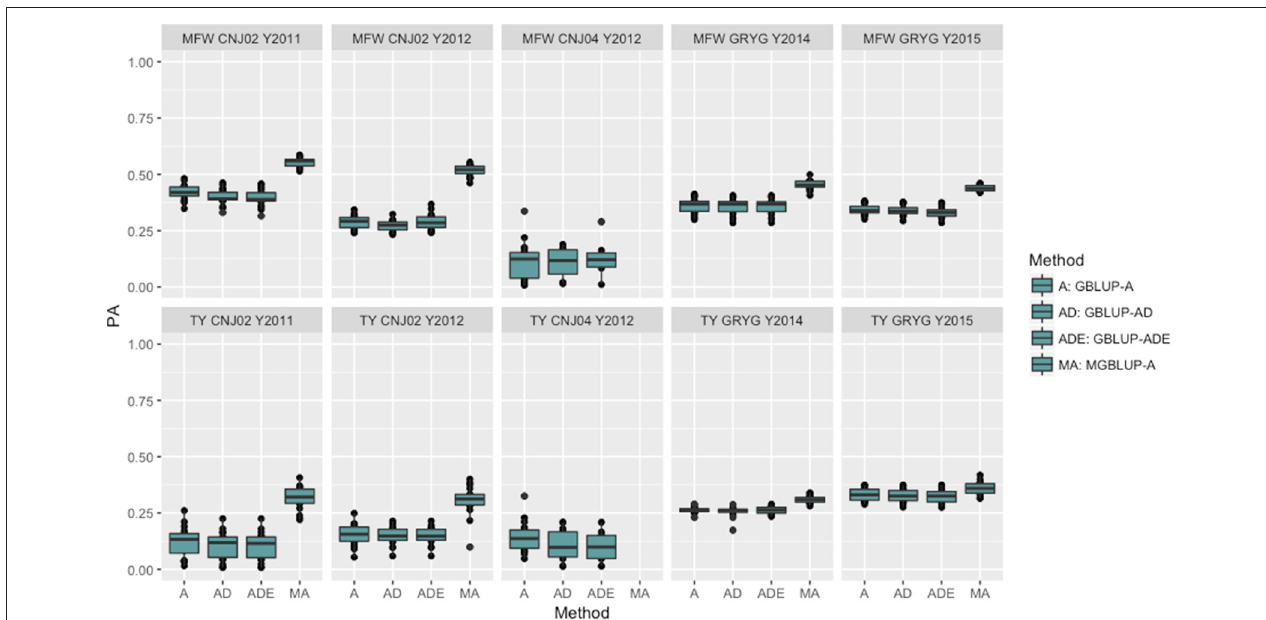
FIGURE 1 | Year-based comparison between univariate and multivariate genomic best linear unbiased prediction methods (GBLUP and MGBLUP) for mean fruit weight (MFW) and total yield (TY) in three cranberry biparental populations. Methods within boxplots are GBLUP using only additive relationship matrix (GBLUP-A), GBLUP using additive and dominance relationship matrices (GBLUP-AD), GBLUP using additive, dominance and epistatic relationship matrices (GBLUP-ADE), and multivariate GBLUP using only additive relationship matrix (MGBLUP). MGBLUP used an additional year of data to form the multivariate response and the genetic correlation among these responses (high genetic correlation